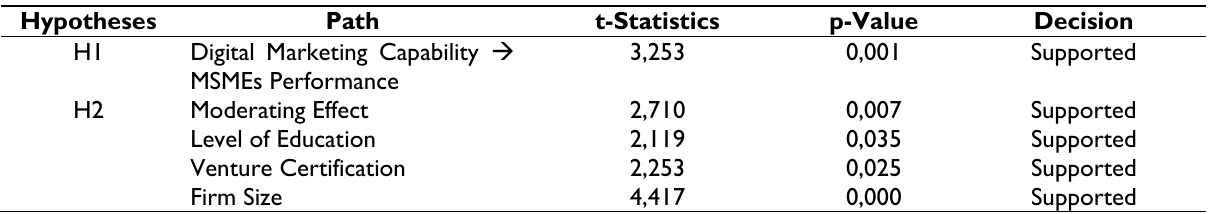
Table 7. Summary of Hypothesis